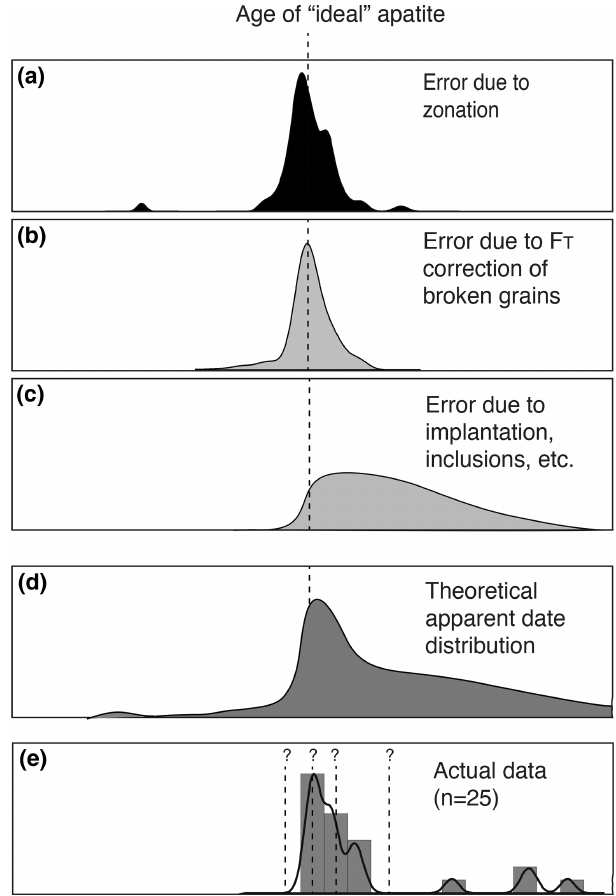
Figure 7. Illustration of how uncertainties due to different com- plications in apatite helium dating – e.g., uncertainty due to zona- tion (a) , uncertainty due to the correction for broken crystals (b) , and error due to implantation and other effects (c) – could together be combined to form a theoretical apparent date distribution (d) that would inform our interpretation of real data and the choice of the ap- propriate summary statistic (whether the minimum, mean, median, or peak date) for representing a sample’s date. Note that (a) is based on actual data from Ault and Flowers (2012) and (b) is based on this study, whereas (c) is schematic. The last panel, (e) , is a representa- tive sample ( n = 25) that shows the expected non-normal and right- skewed distribution from an actual large- n sample (He et al., 2019; Thomson et al., 2019). The peak date in this case would likely ap- proximate the date of an “ideal” apatite, but a full accounting of the probability of various uncertainties would provide a more robust ra- tionale for that